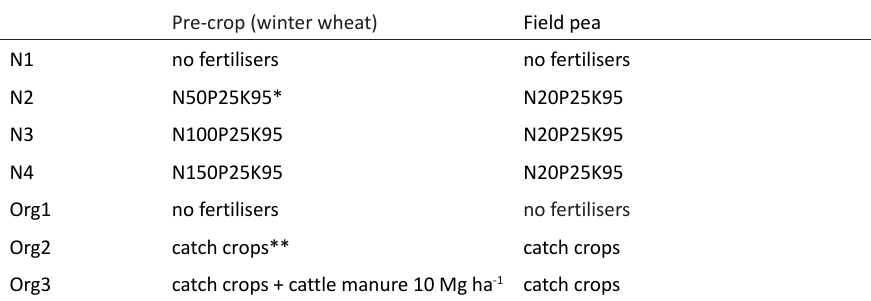
Table 1. Different fertiliser treatments of preceding crop and field pea in 7 different cropping systems Pre-crop (winter